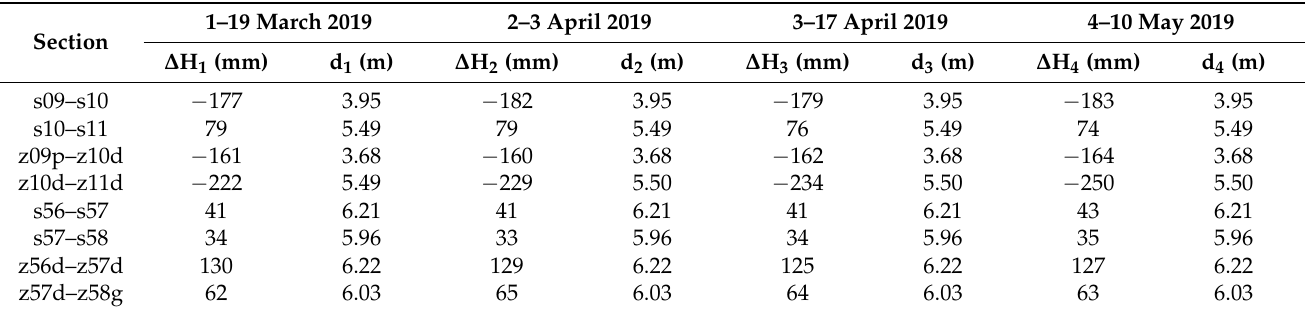
time period of March–May